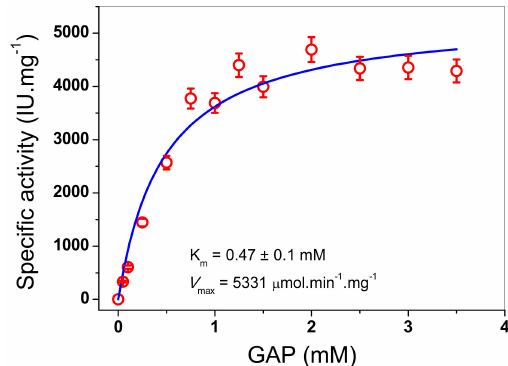
Figure 6. Determination of pH and temperature on the activity of FoxTPI. The e ff ect of pH on the activity of kinetic plots of the FoxTPI determined with GAP. Initial velocity data were obtained varying substrate concentration, indicated in the abscissa axis, and fitted to the Michaelis-Menten equation. The data represent mean ± SD from three independent